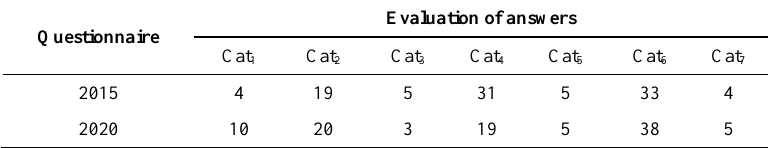
Table 7. Comparison of the views of the future operation of the ammunition storage site after the completion of the